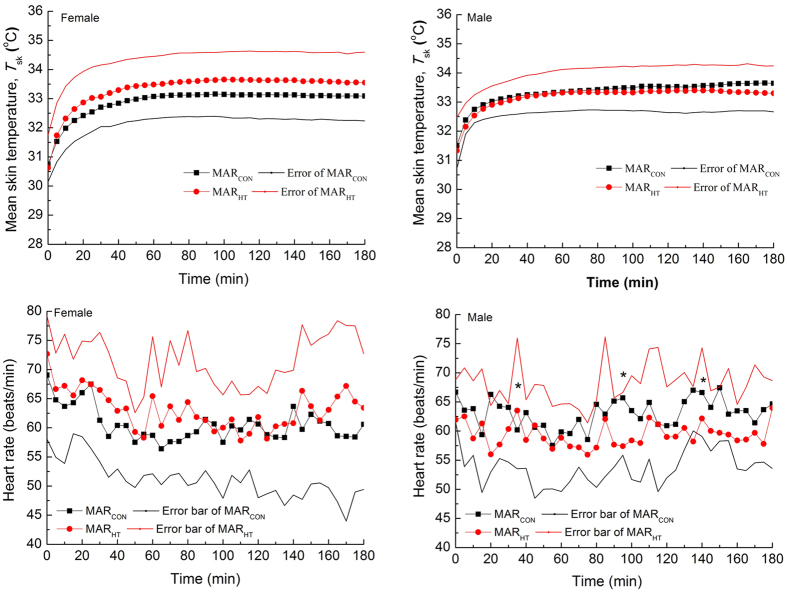
The evolution curves of the mean skin temperature and heart rate for females and males in MARCON and MARHT.